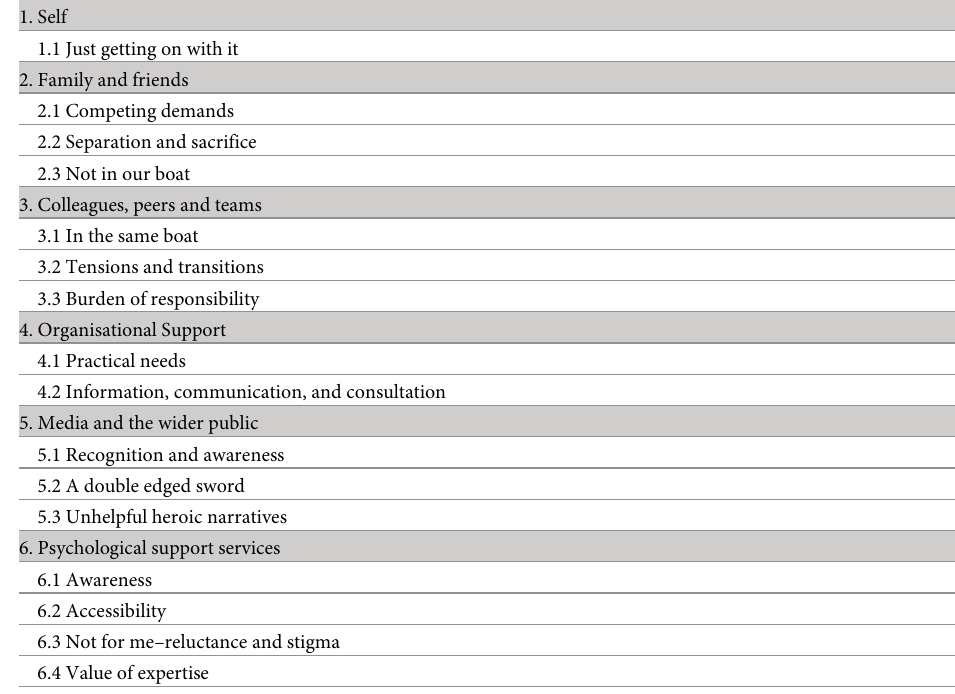
Table 2. Themes (organised within domains of